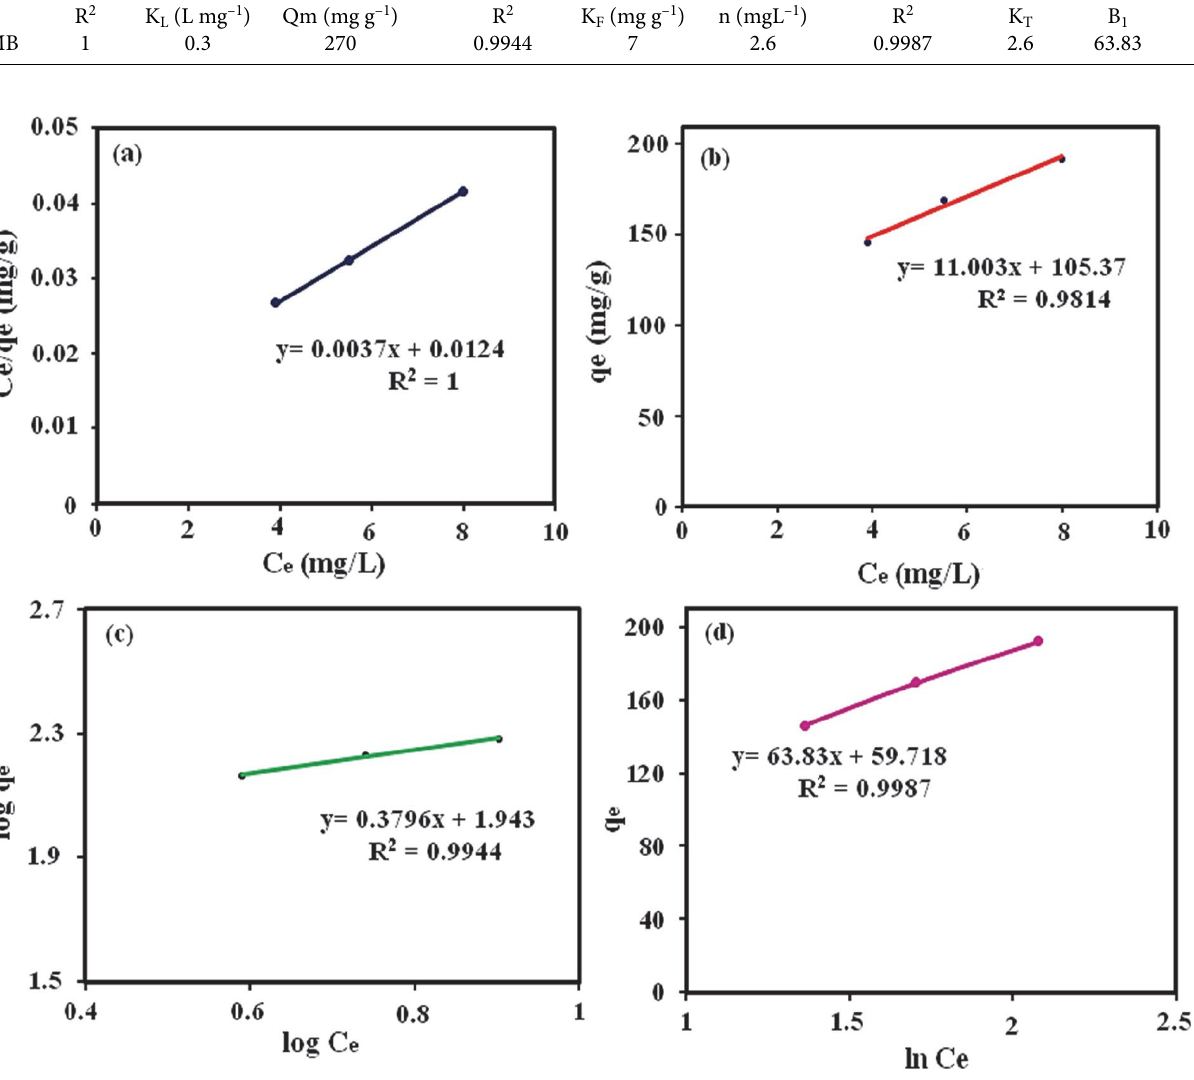
Figure 13. (a) Isotherm plot of dye elimination, (b) Langmuir isotherm, (c) Freundlich isotherm, (d) Temkin isotherm of dye removal by P 2 W 18 @ MIL-101